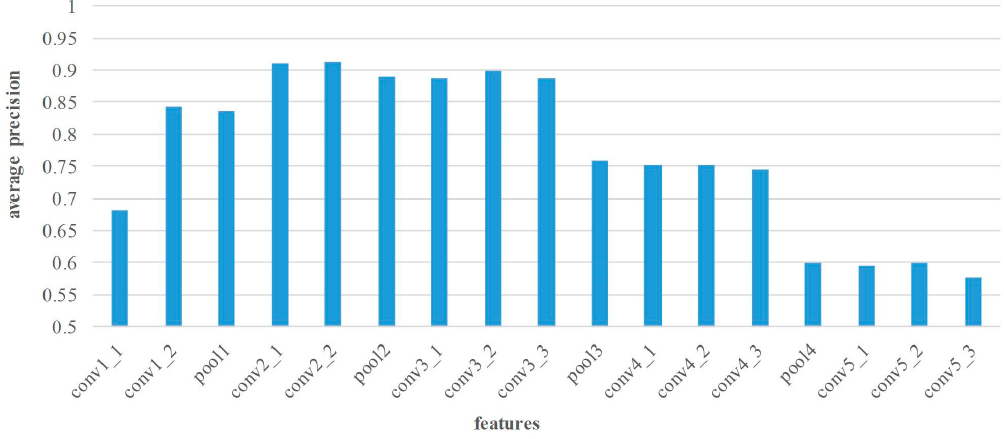
Figure 5. Average matching precision comparison of various layers’ features on Middlebury dataset. The horizontal axis denotes the various layers’ features, and the vertical axis is the average matching precision.